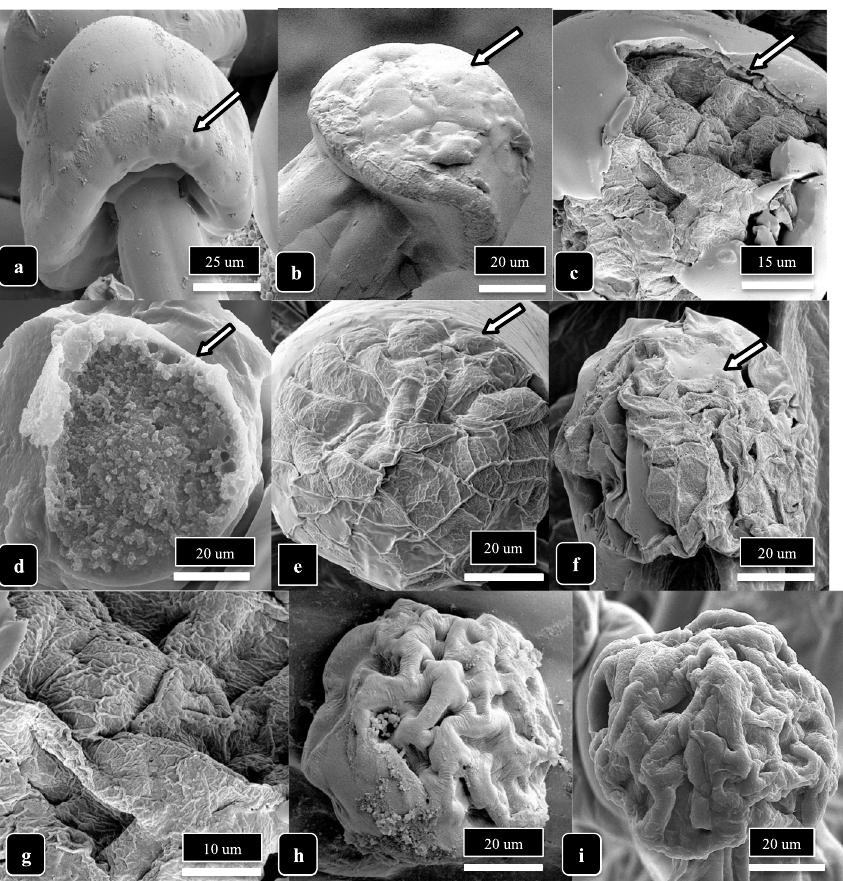
Fig. 10 The process of trichome head senescence is shown. a Fully developed head with intact cuticle. No secretion of resin or shrinkage of the cuticle has occurred. Arrow points to the ring of secretory disc cells. b Shrinking of the cuticle and shriveling of the head has occurred, likely due to resin secretion. c , d Rupture of the cuticle (arrow) shows the dense granular appearance that is the resinous material underneath. e – f Shrinkage and collapse of the cuticle on mature glandular heads. The secretion of resin causes an aggregation of underlying resinous material and the surface of the head appears convoluted and wrinkled (arrows). g Close-up of dried resinous material. h , i Dried convoluted appearance of glandular heads that are completely